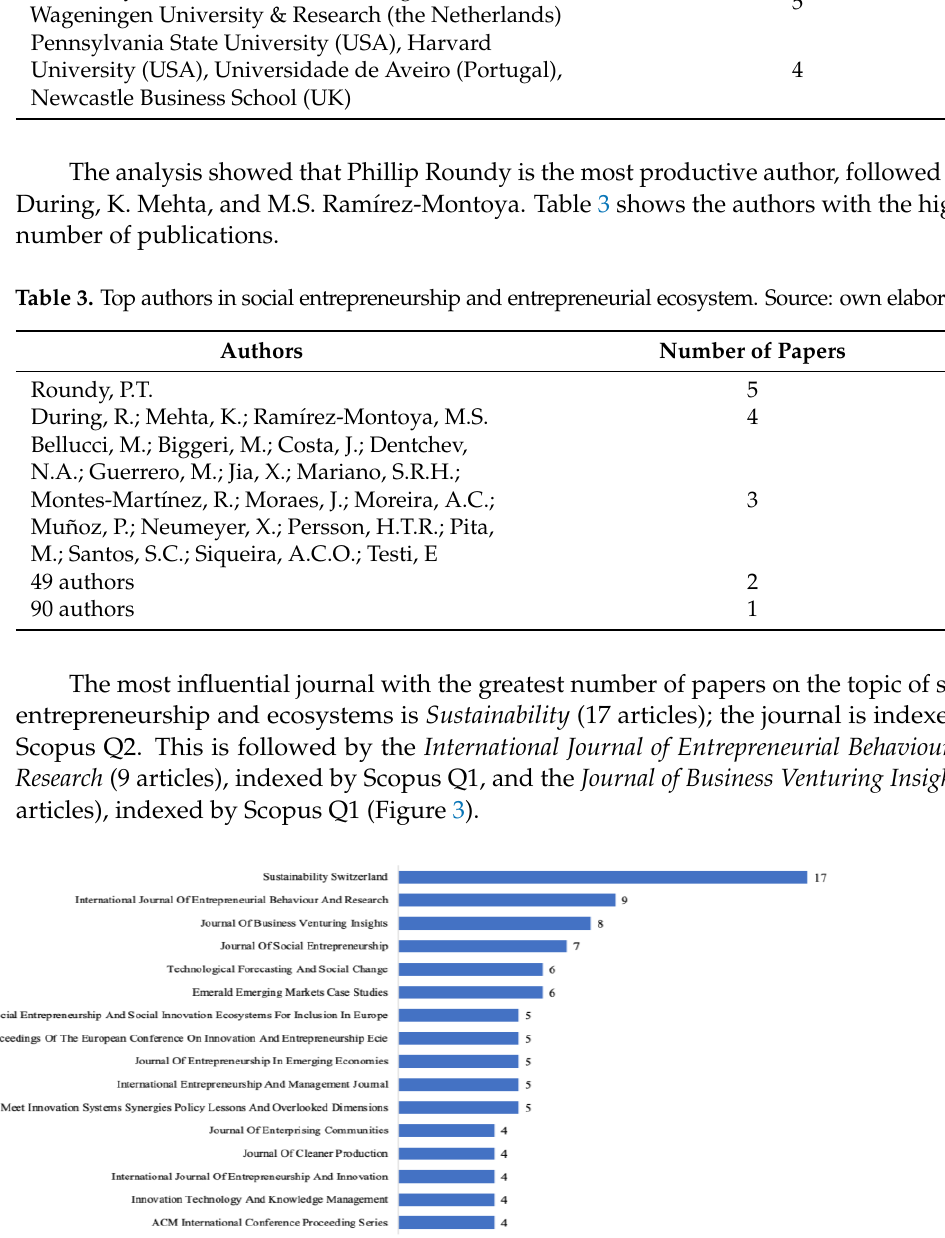
Figure 3. Top influential journals on social entrepreneurship and the entrepreneurial ecosystem. Source: own elaboration.